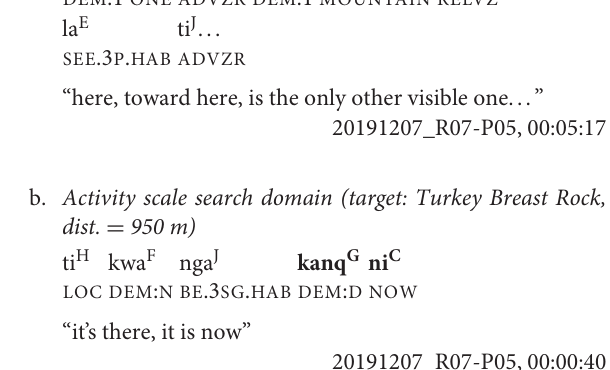
FIGURE 2 | Activity scale [target: Peak of kyqya C kcheq B ].